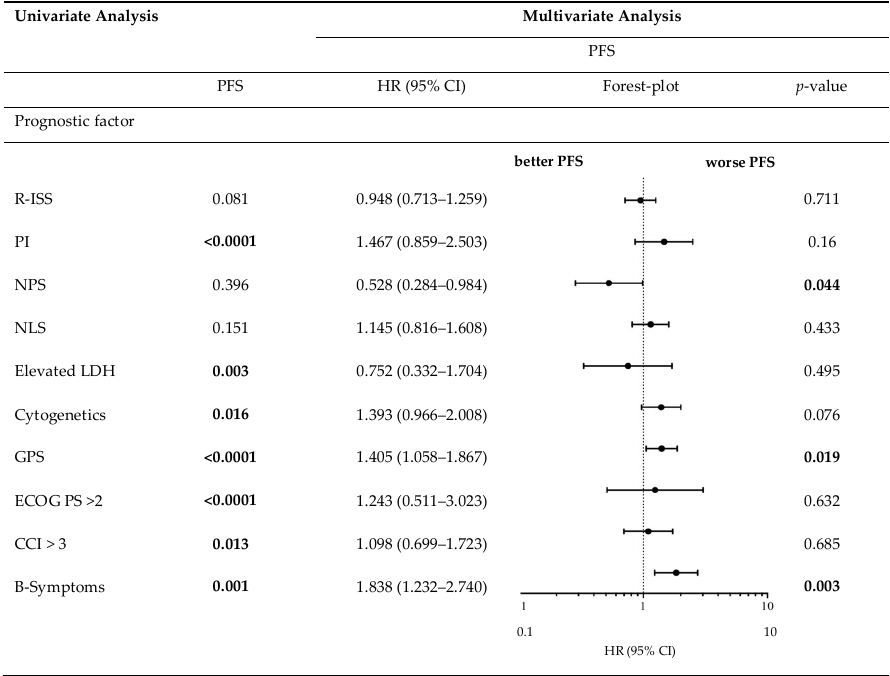
Table 7. Progression-free survival in univariate analysis and consecutive multivariate Cox proportional hazard regression.